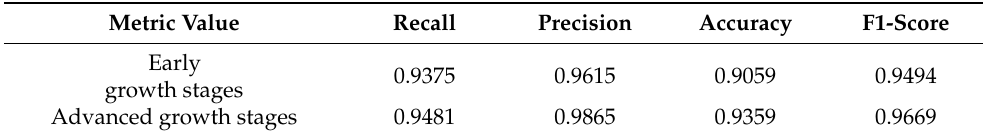
Table 4. Recall, Precision, Accuracy and F1-score separately for lettuce plants at early growth stages and advanced ones.